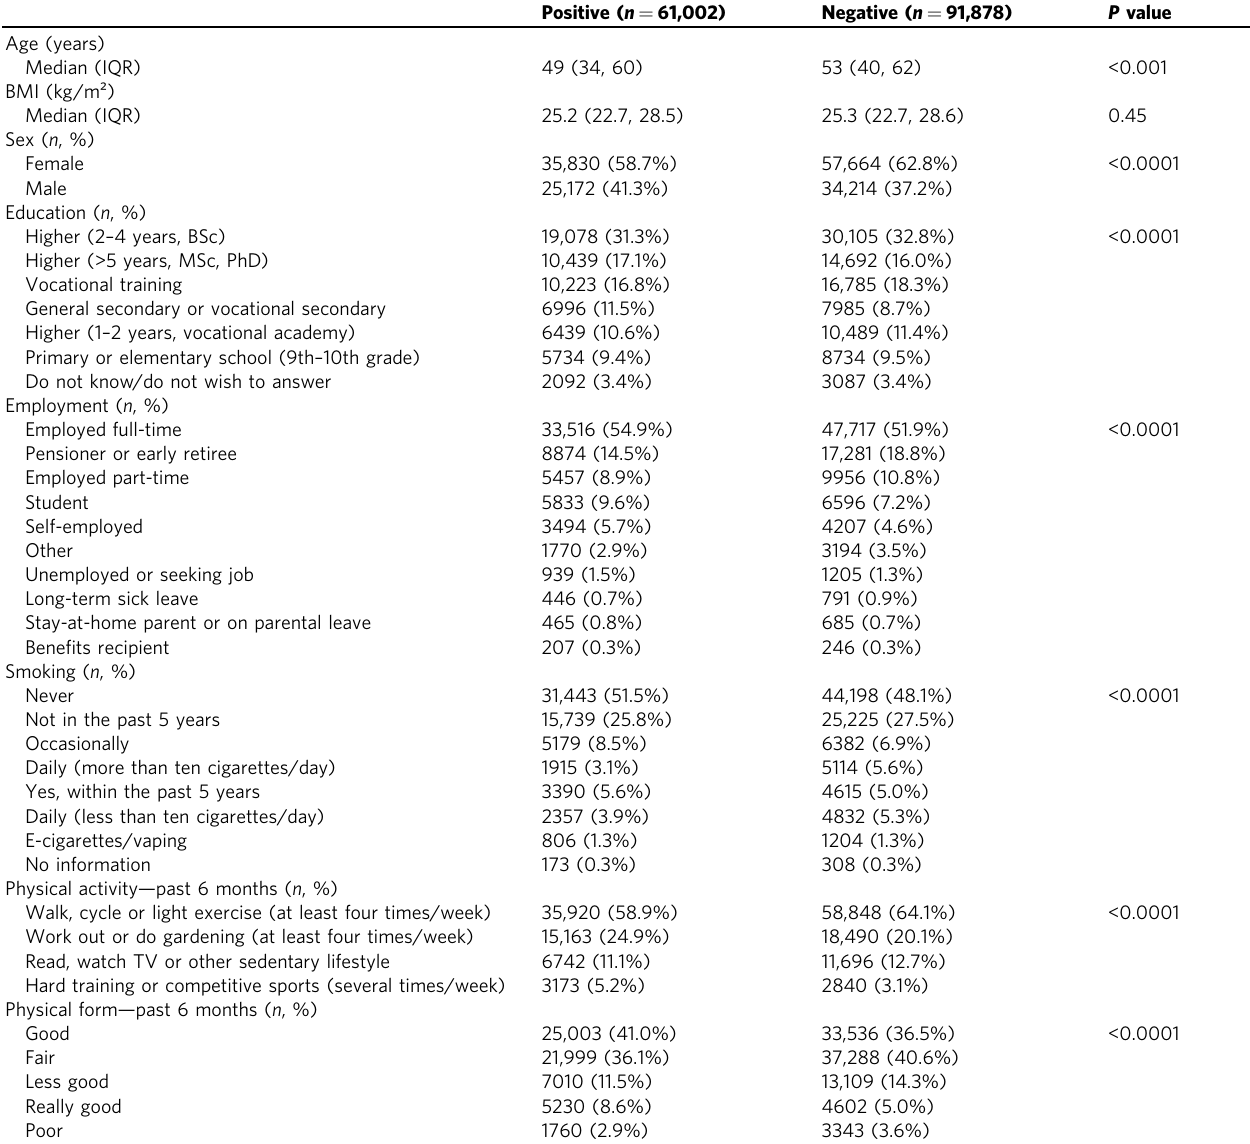
Table 1 Characteristics of 152,880 participants tested for SARS-CoV-2, September 1, 2020 – April 2,